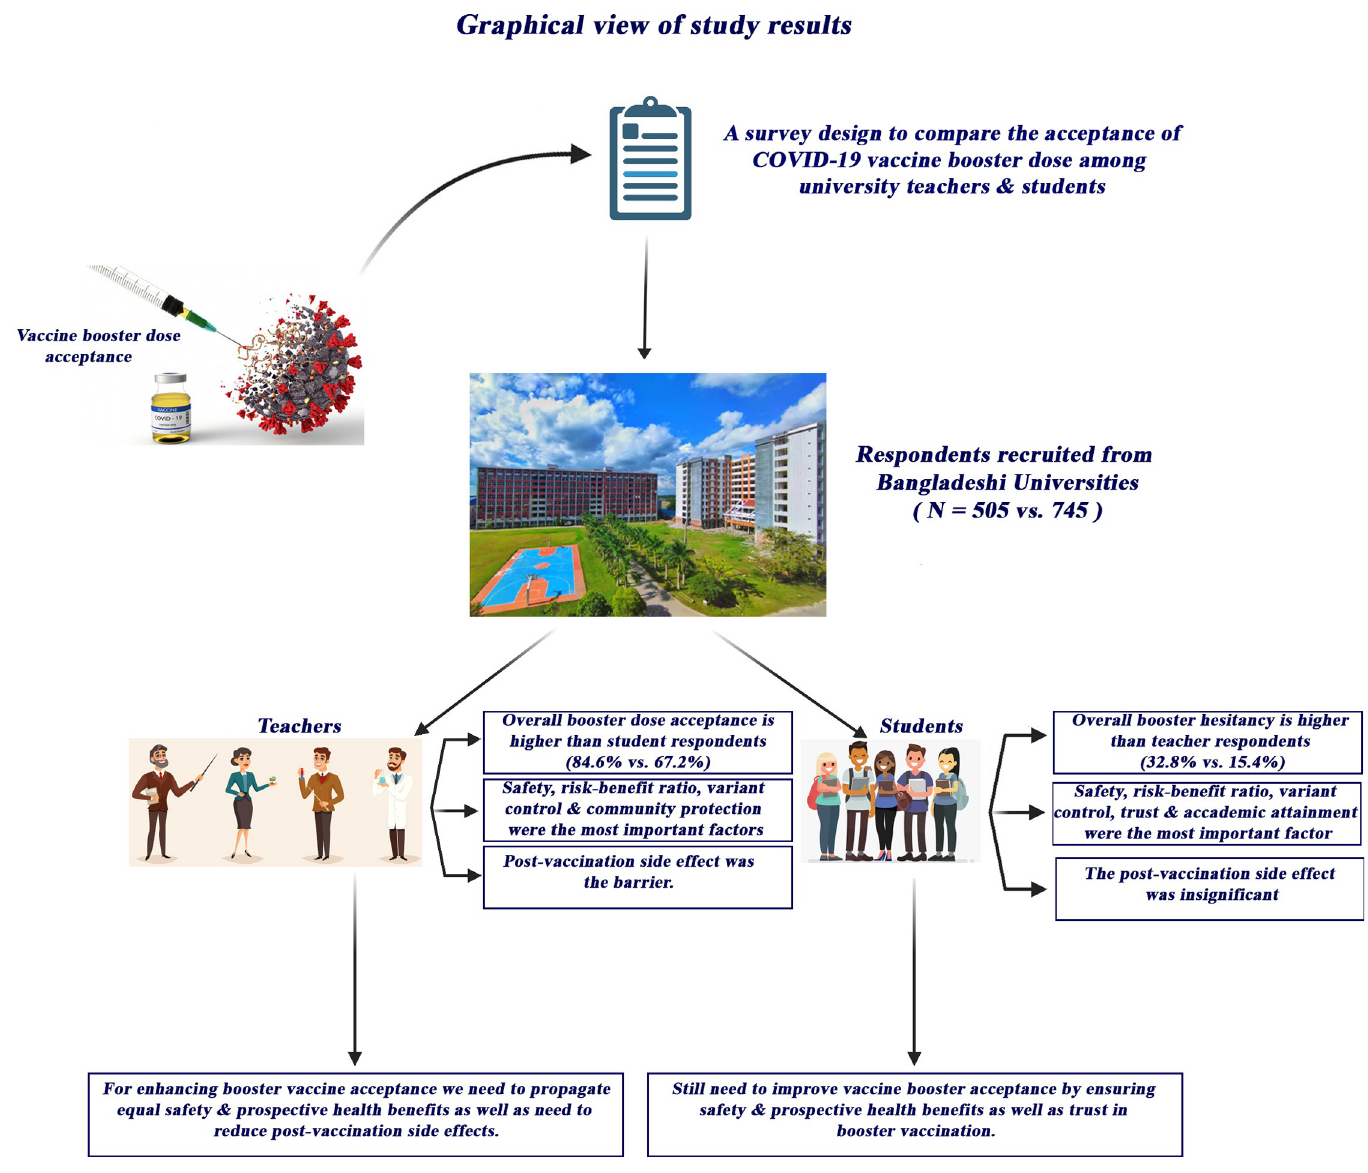
Fig 1. Graphical overview of the study